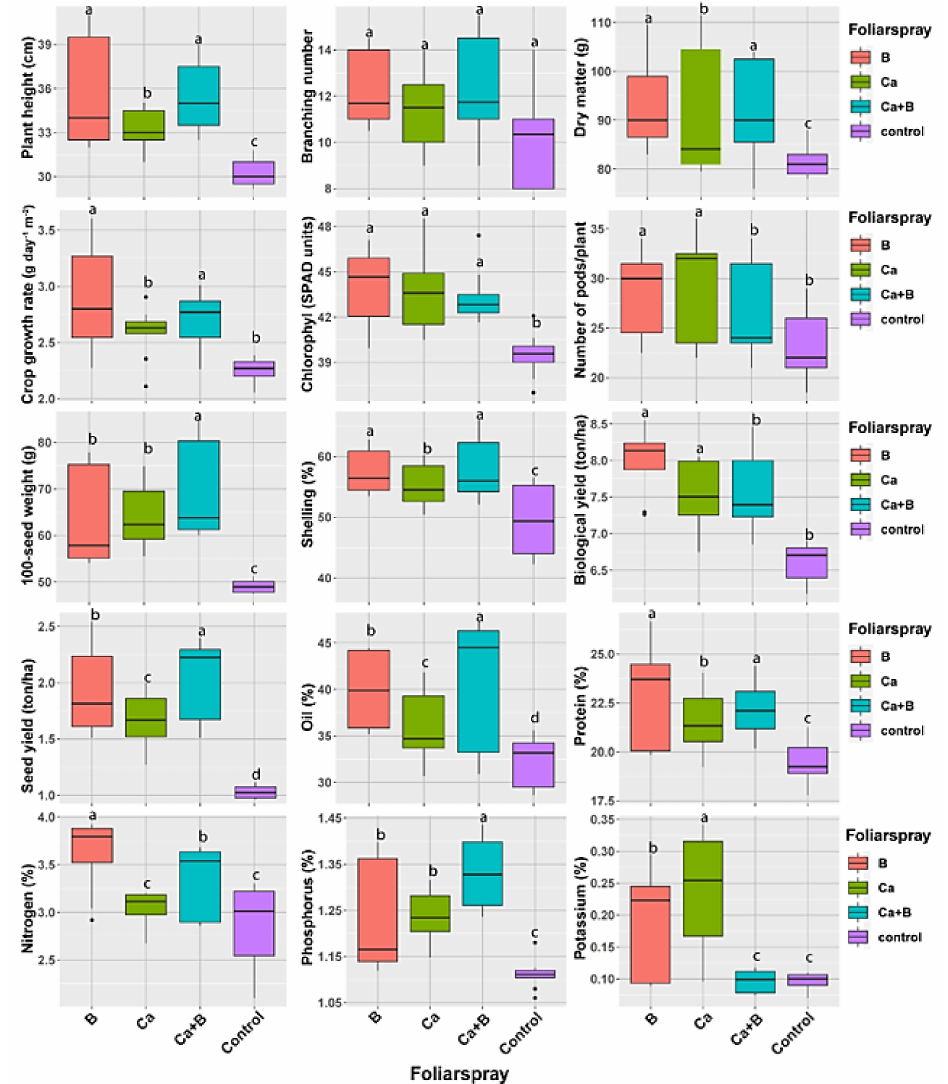
Figure 2. Effects of different fertilization regimes (B, Ca, and Ca+B nanoparticles) on growth, yield, and biochemical traits of peanuts during two growing seasons (2020 and 2021). Different lowercase letters on error bars indicate statistically significant differences between treatments ( p ≤ 0.05), as performed by the least significant difference (Fisher’s LSD)